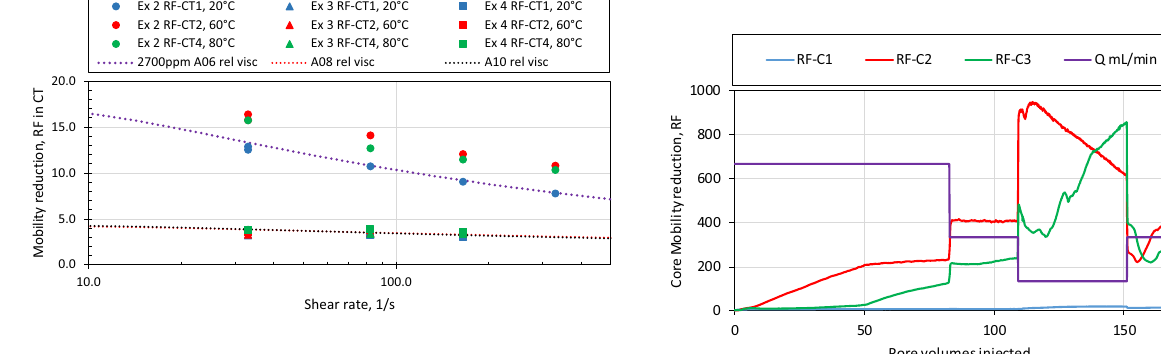
Fig. 11 RF CT as a function of shear rate in the Capillary tubes (CT) in Experiment 2 – 2700 ppm A06, Experiment 3 – 1000 ppm A08 and Experiment 4 – 1000 ppm A10, all in SSW. The squares are used for Experiments 4, triangles for Experiment 3 and circles for Experi- ment 2. Blue markers are used for 20 °C, red for 60 °C and green for 80 °C. The dashed lines are the relative viscosities from the Carreau model (Eq. 4 . ) fitted to measurements performed with Anton Paar Rheometer at 20 °C